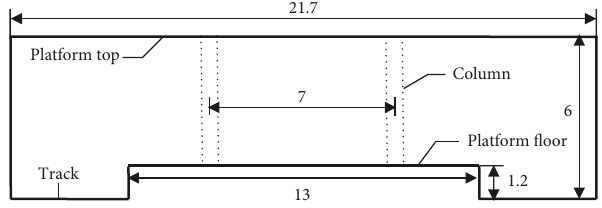
Figure 2: Cross-sectional dimension of subway platform (unit: